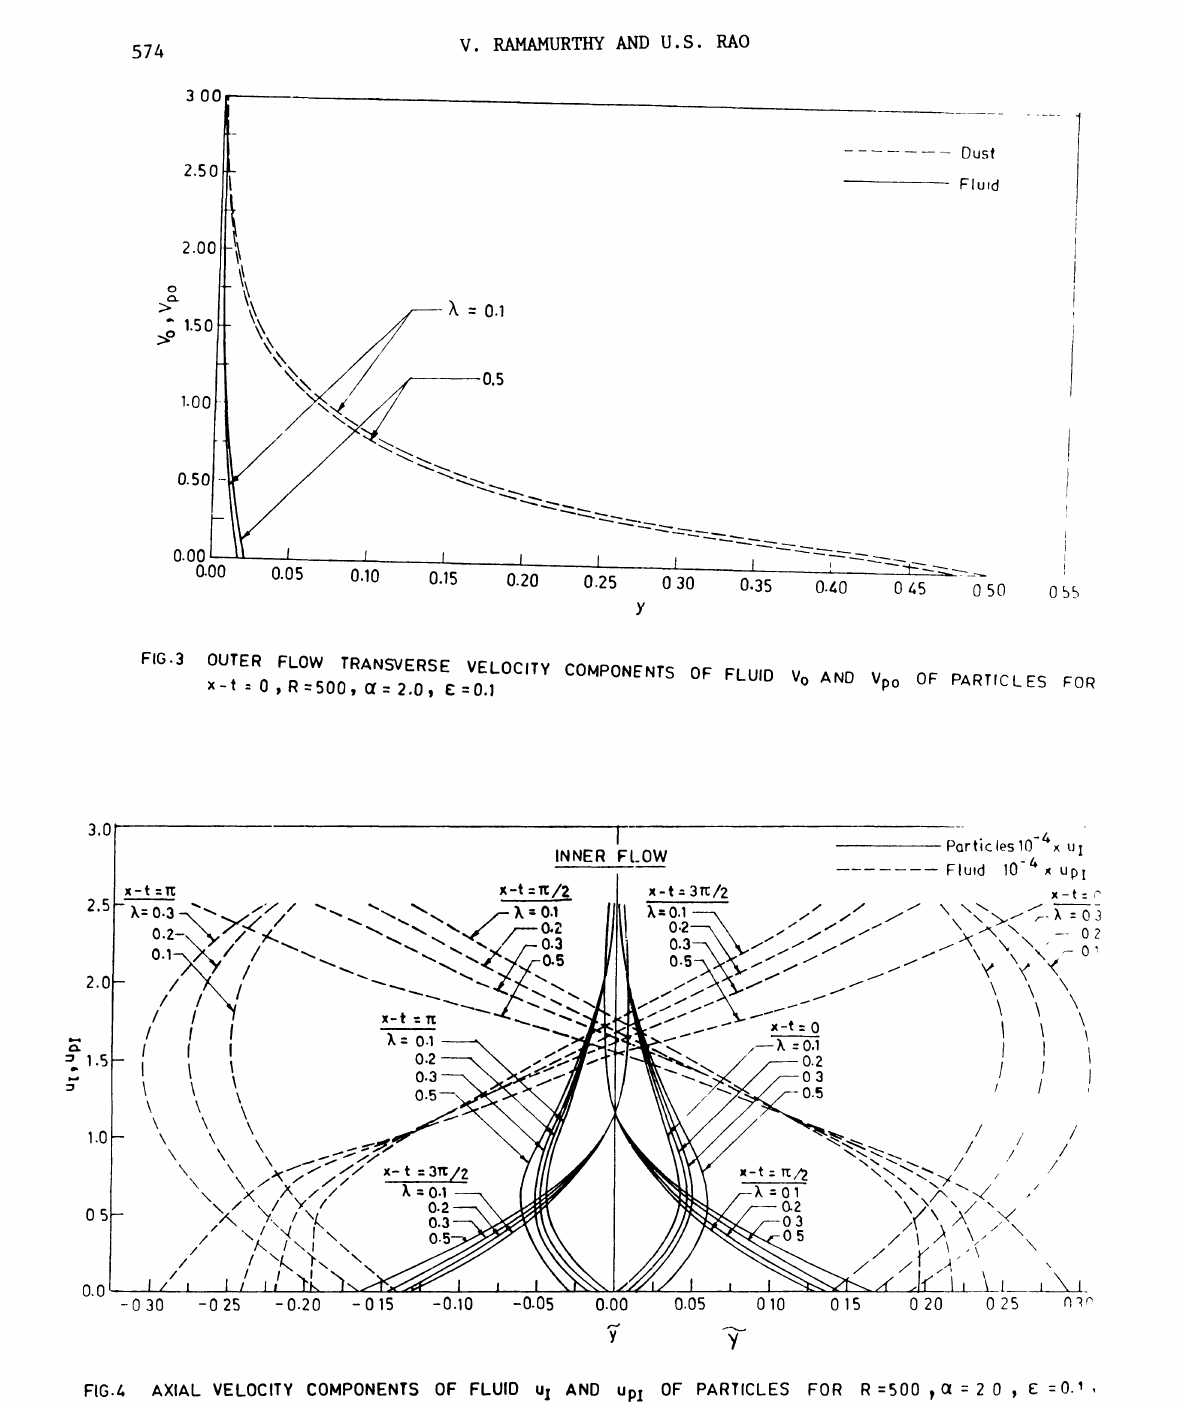
FIG.4 AXIAL VELOCITY COMPONENTS OF FLUID u AND Upl OF PARTICLES FOR R =500